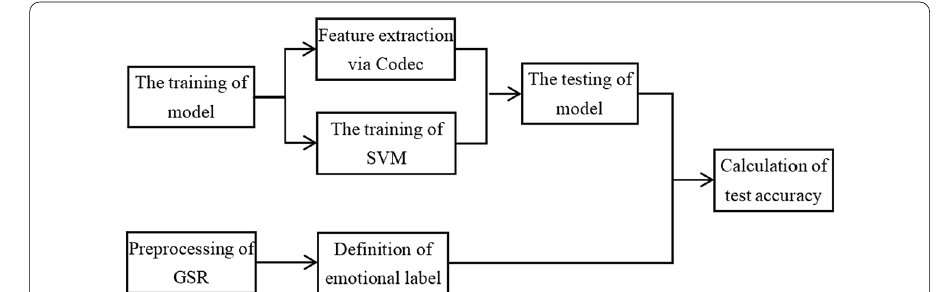
Fig. 9 The overall structure of the emotion recognition model